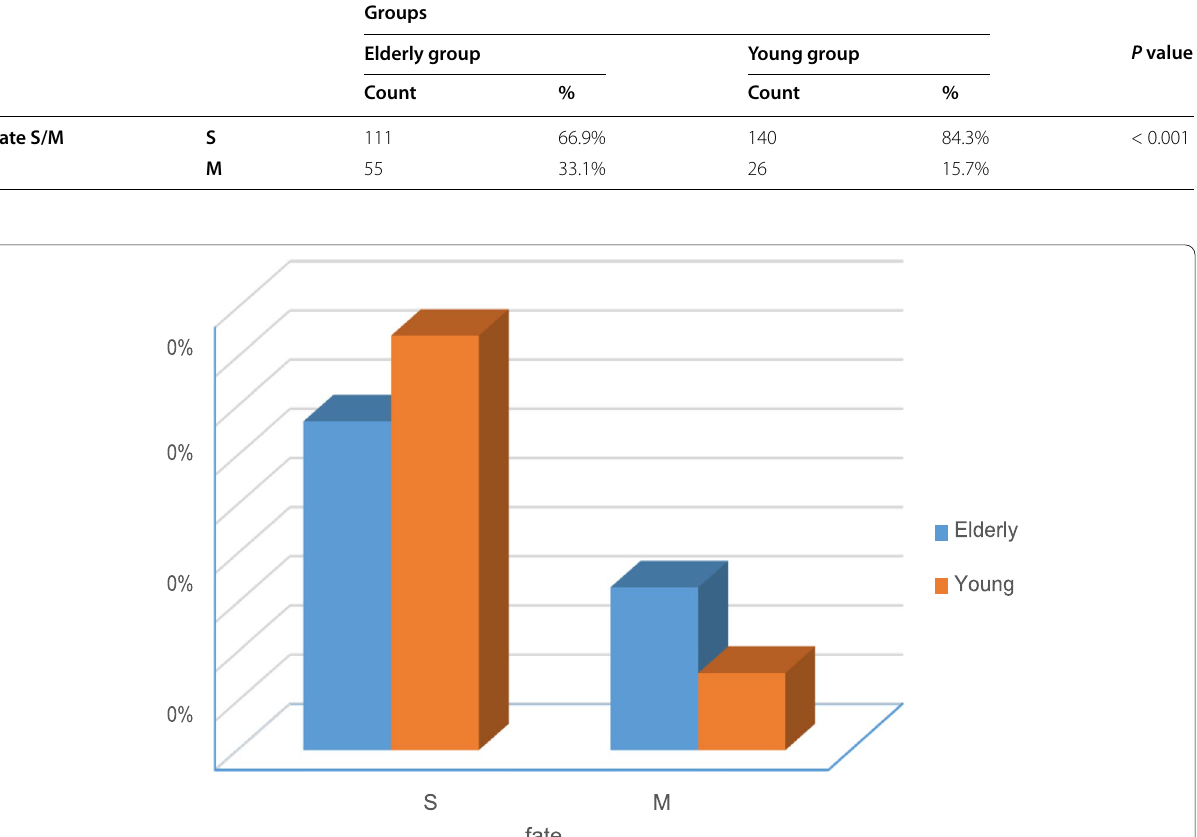
Table 8 Comparison between both groups regarding mortality